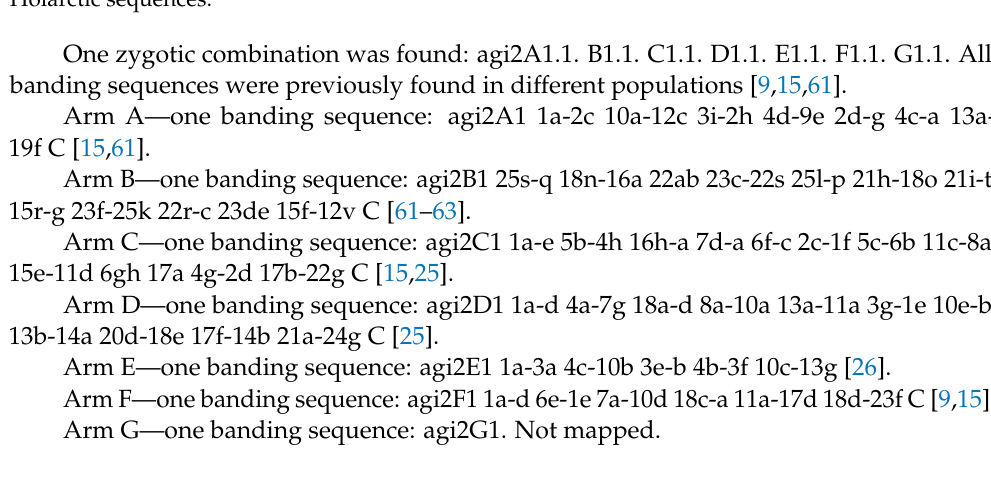
Figure 2. Karyotype of Chironomus agilis 2 from Kurchatskoe Lake, Tyumen, Russia. Arrows indicate centromeric bands; p’agi2A1, p’agi2B1, etc., genotypic combinations of banding sequences in chromosome arms; BR, Balbiani rings; N, nucleolus; and prefix p’ for Palearctic sequences, h’ for Holarctic sequences.